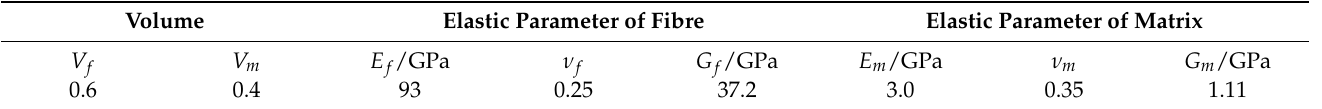
Table 13. Performance parameters of H-GFRPs components under the RT condition. Volume Elastic Parameter of Fibre Elastic Parameter of